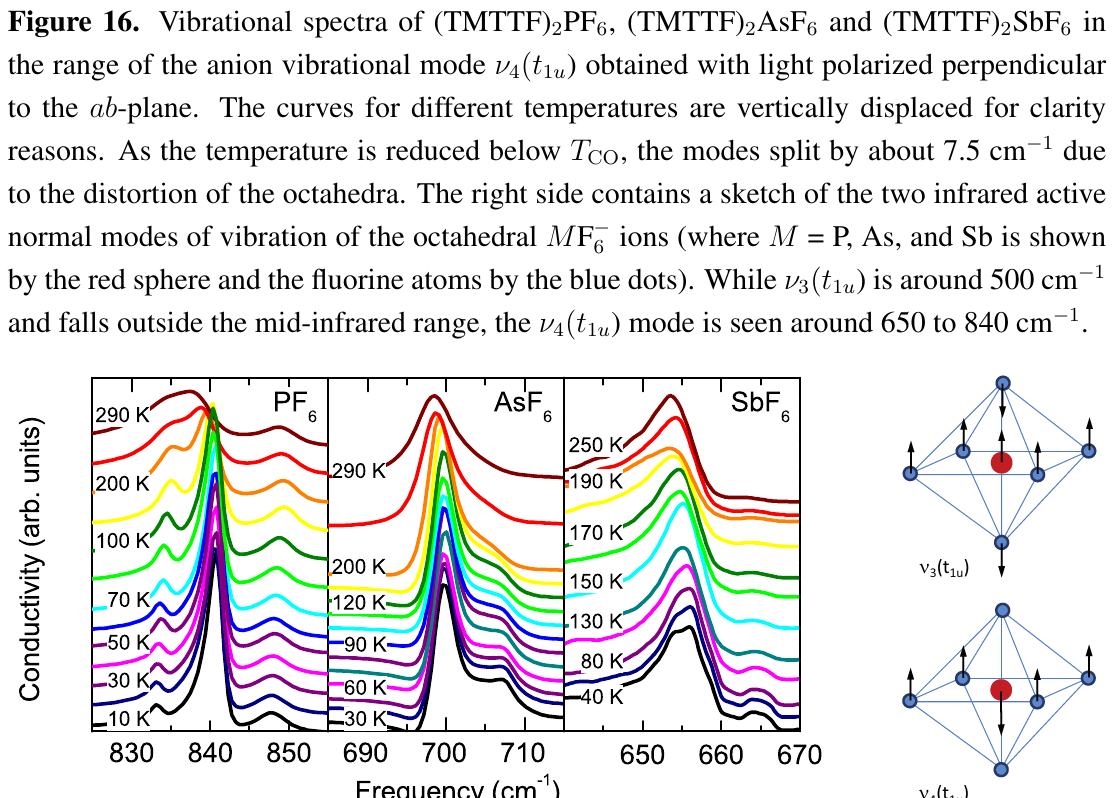
In Figure 16 the conductivity spectra of (TMTTF) presented in the narrow range around the ν At room temperature, the vibrational features are located at ν at 699 cm − 1 for (TMTTF)